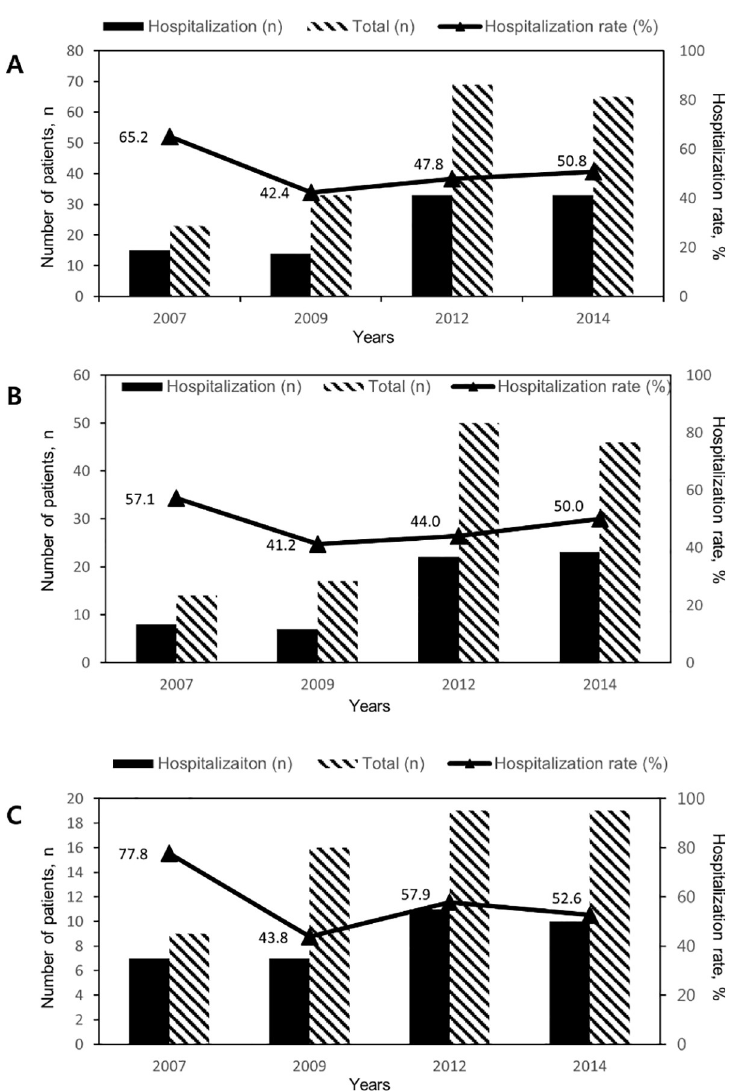
Fig 2. Hospitalization rates of patients with IBD (A), CD (B), and UC (C) visiting ED stratified by years. There was no significant linear trend for hospitalization rates of ED patients ( P = 0.587).